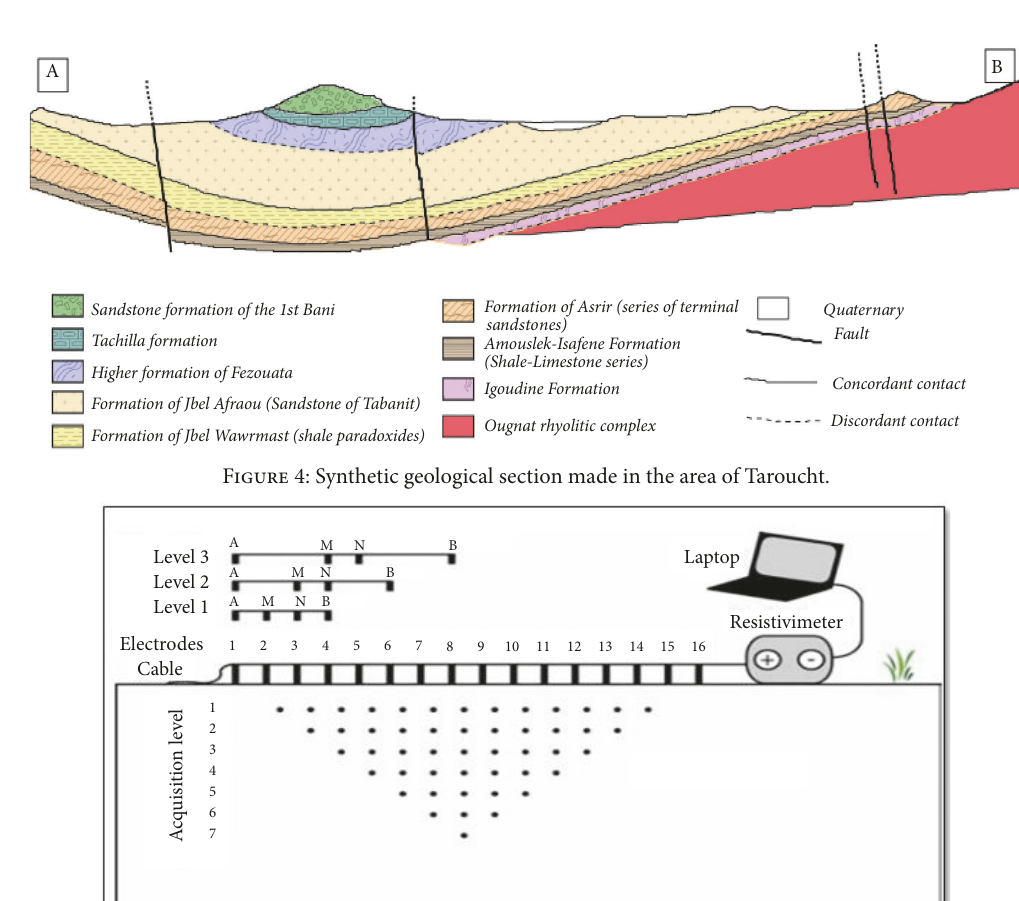
Figure 3: General structural scheme of the Eastern Anti-Atlas.